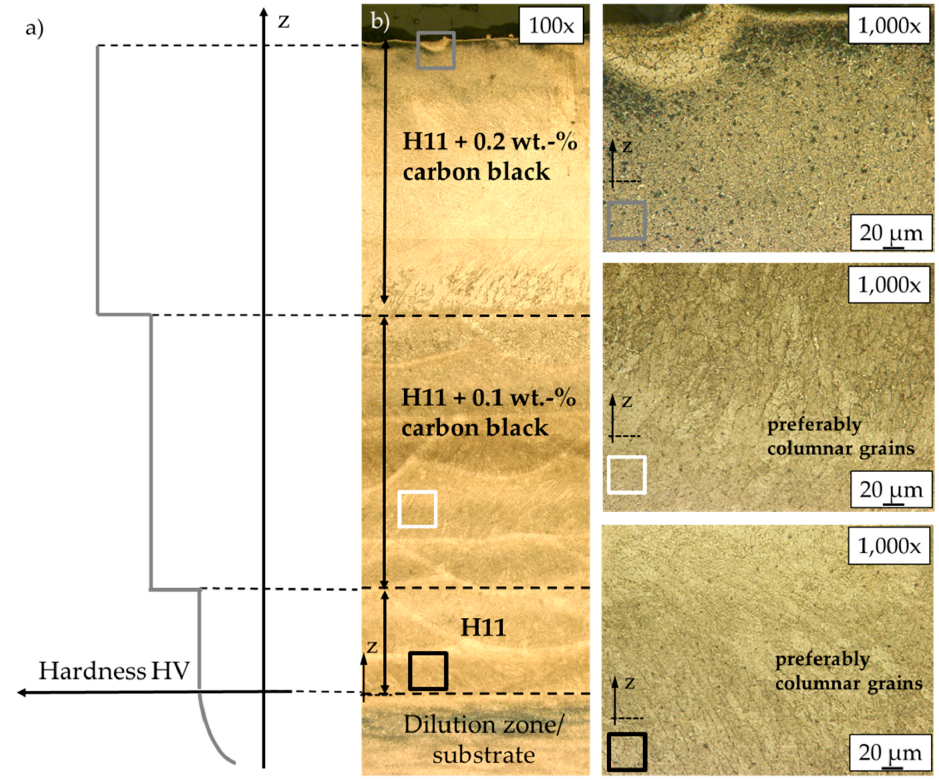
Figure 16. ( a ) Idealized illustration of the desired hardness profile with respect to the sample height and the concentration of added carbon black nanoparticles; ( b ) local microstructure of the graded sample with respect to the sample height in varying magnifications (magnifications: 100 × , 1000 ×